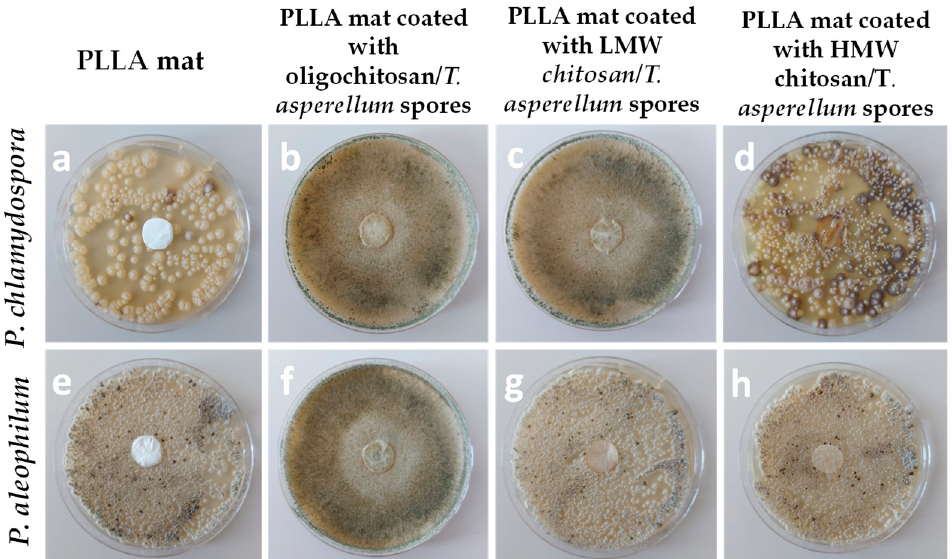
Figure 8. Digital images of the test on the behavior of the mats: PLLA mat, PLLA mat coated with oligochitosan/ T. asperellum spores, PLLA mat coated with LMW chitosan/ T. asperellum spores, and PLLA mat coated with HMW chitosan/ T. asperellum spores against P. chlamydospora ( a – d ) and P. aleophilum ( e – h ) [115].